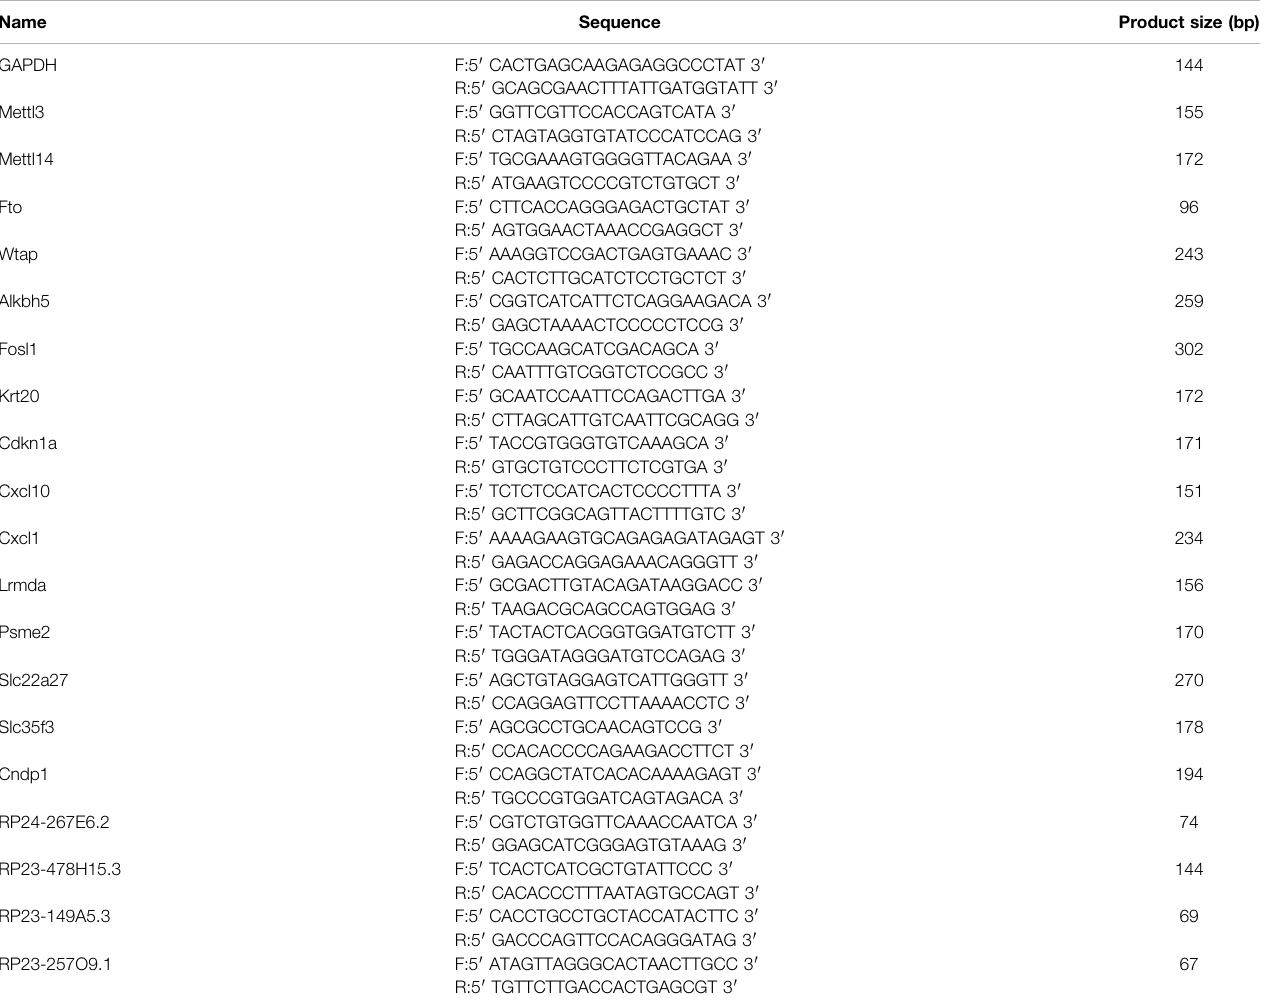
TABLE 1 | Sequences of primers used for qPCR and MeRIP-qPCR